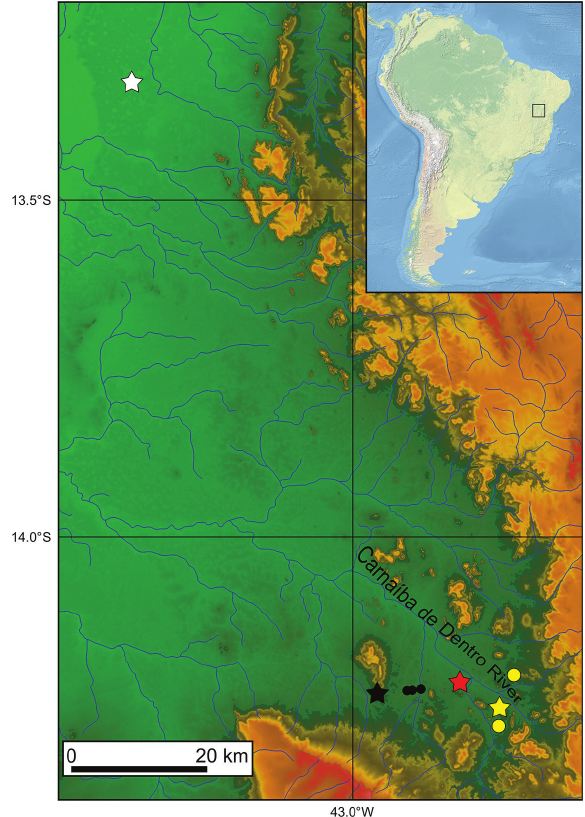
Figure 4. Geographical distribution of species of the Hyp- solebias J’-clade in the upper Carnaíba de Dentro River drain - age (yellow, H. fulminantis ; red, H. splendissimus ; black, H. carlettoi ) and H. shibattai (white); stars indicate type